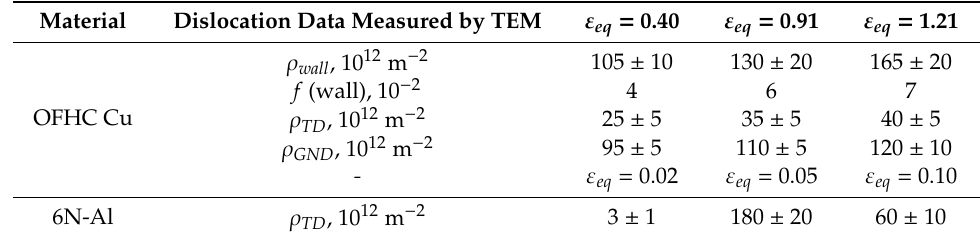
Table 4. Dislocation density and dislocation wall volume fraction, f, for OFHC Cu at ε eq = 0.40, 0.91, and 1.21; Tangled dislocation density, ρ TD , for 6N-Al at ε eq = 0.02, 0.05, and 0.10.